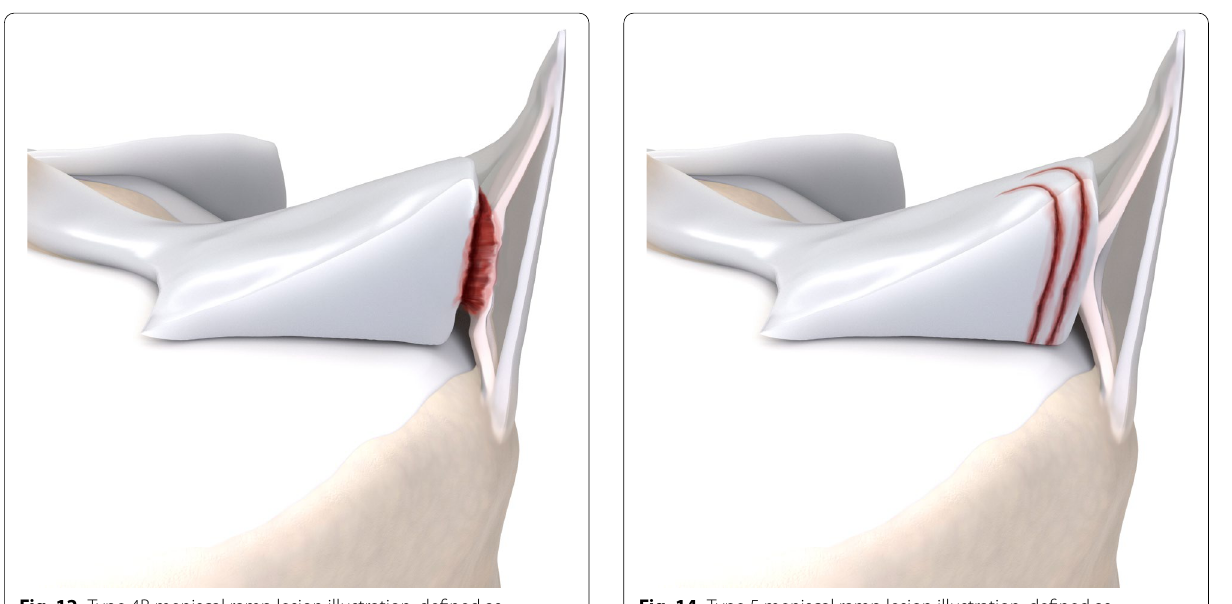
Fig. 12 Type 4B meniscal ramp lesion illustration, defined as complete meniscocapsular junction tear